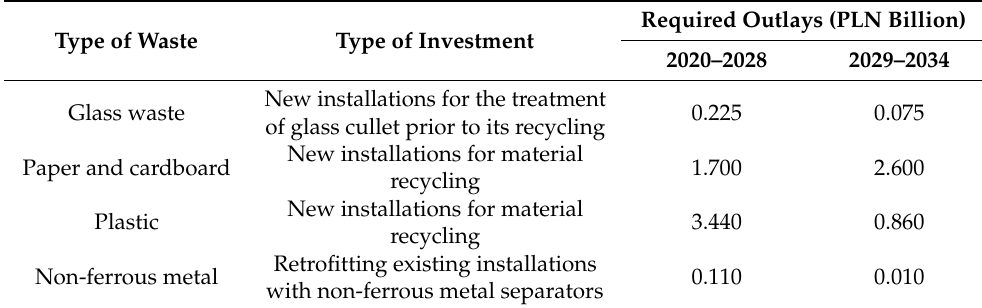
Table 1. List of investment outlays for selected types of waste in the example of Poland. Type of Waste Type of